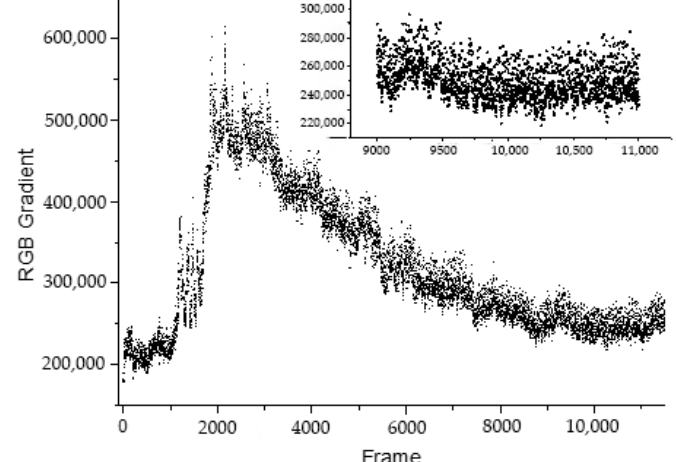
Figure 2. Variation of RGB color gradient with time in a beaker under 100 rpm stirring, among which the inset image is an enlargement of local data.